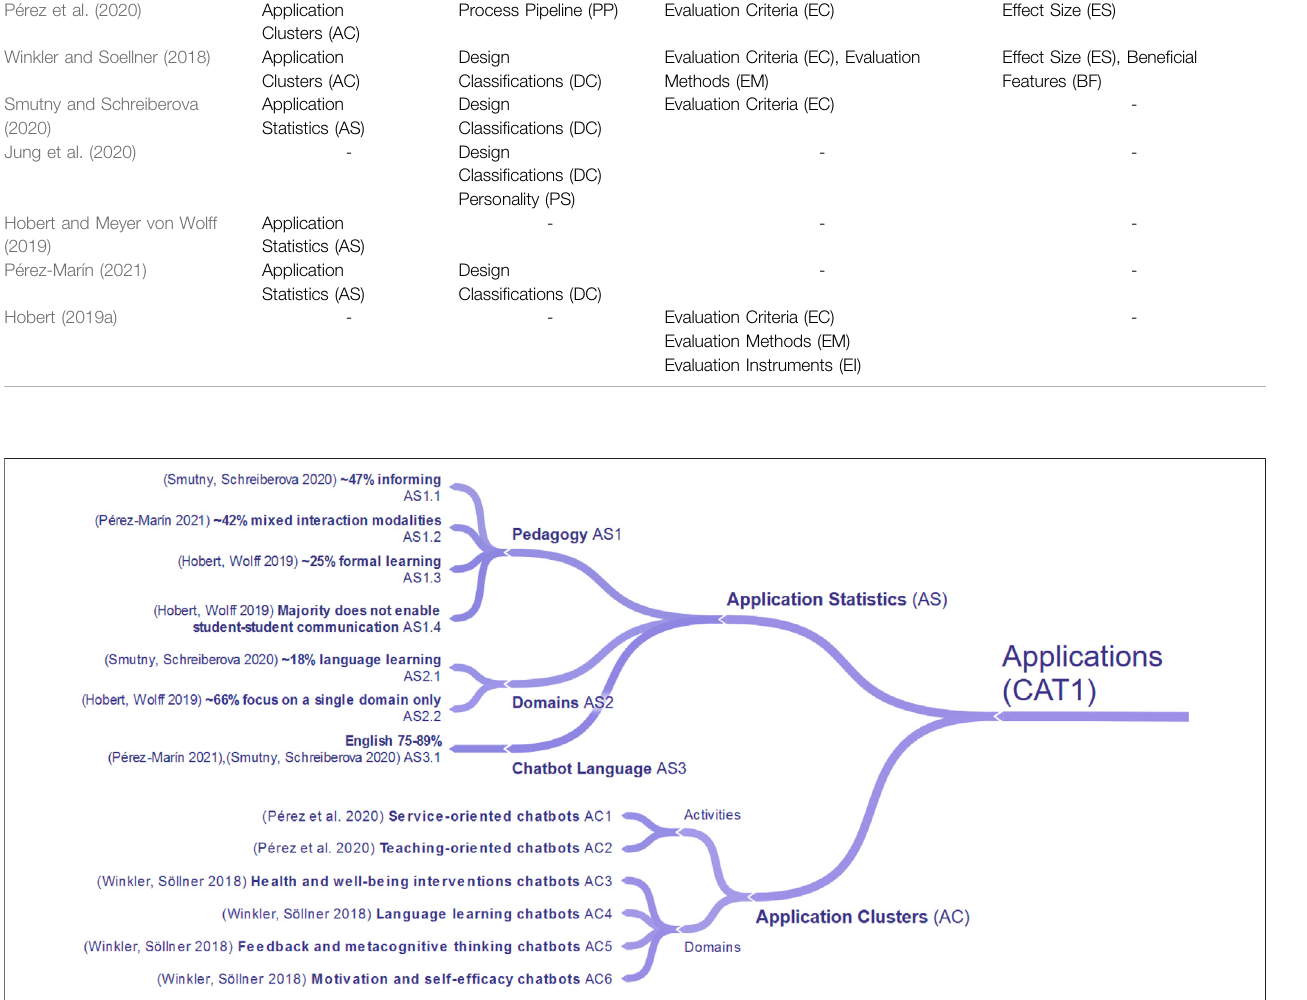
category visualized in Figure 2 : Personality (PS), Process